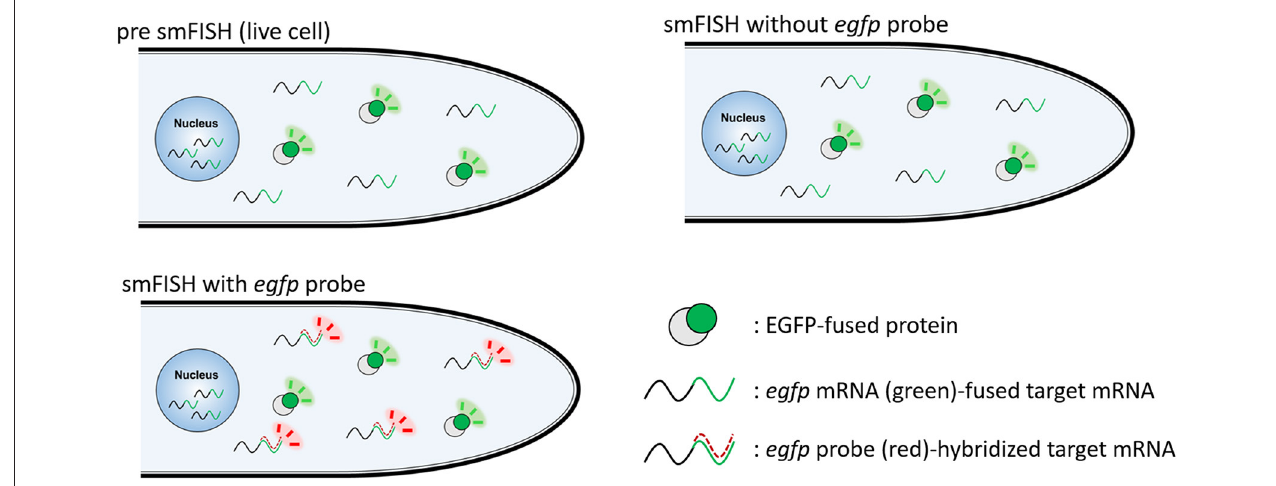
FIGURE 1 | Schematic diagram to visualize EGFP-fused protein and its transcript by smFISH. EGFP-fused protein is visualized in live cells. smFISH without egfp probe results in the fluorescence of EGFP-fused protein. smFISH with egfp probe results in the fluorescence of both EGFP-fused protein and egfp probe-hybridized mRNA.